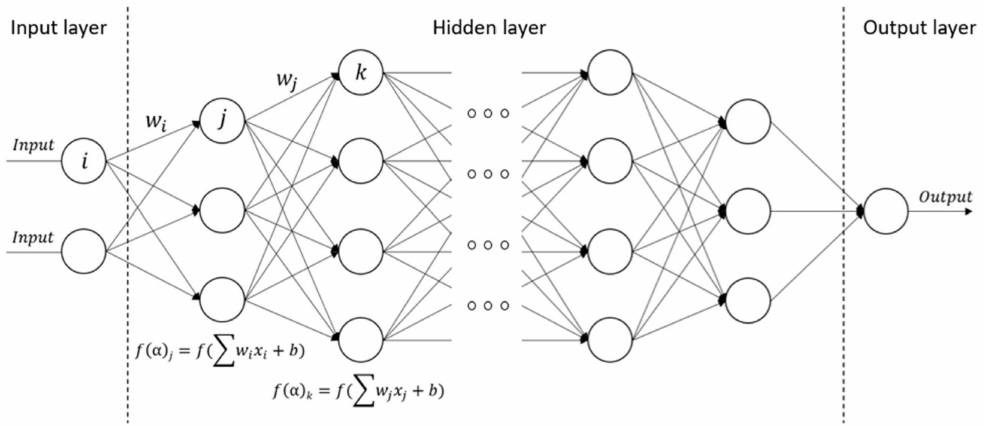
Figure 3. Deep neural network architecture